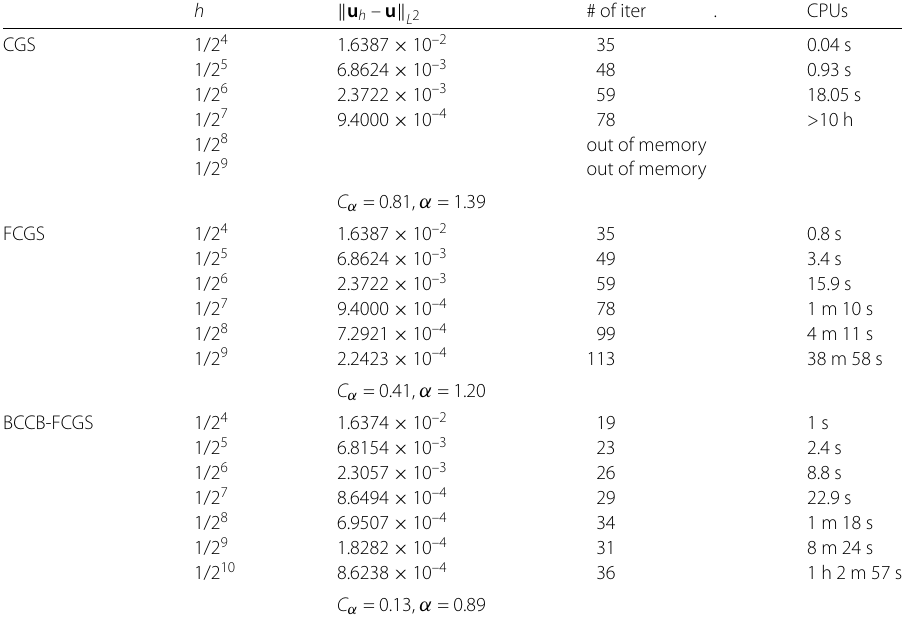
Table 2 Performance of CGS, FCGS, and BCCB-FCGS in Example